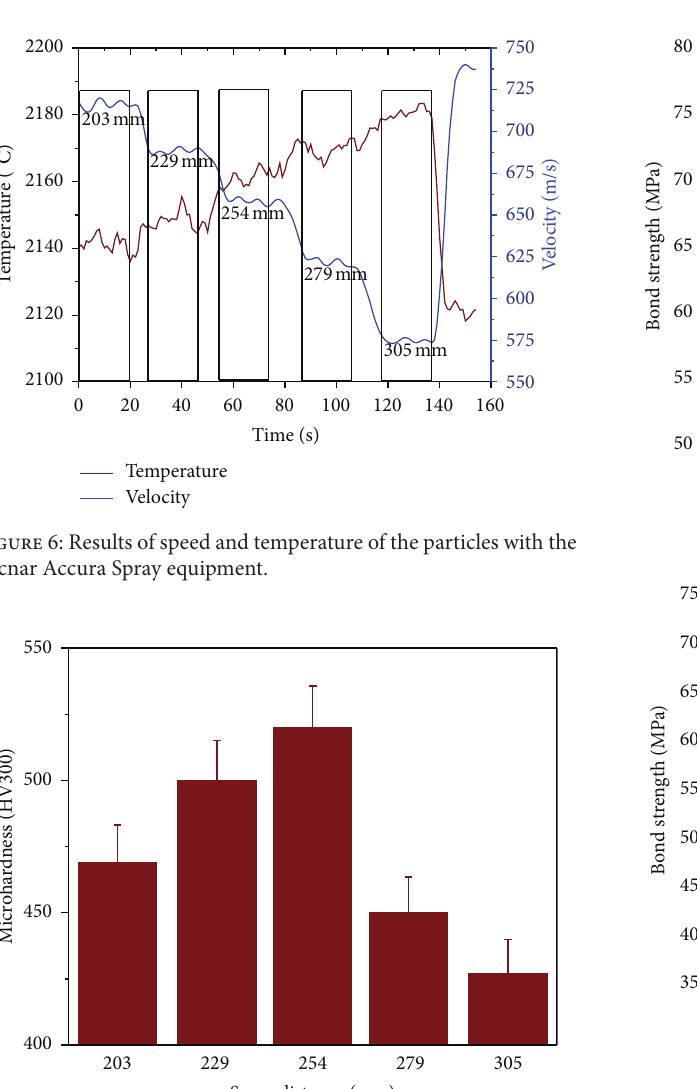
Figure 7: Microhardness Co 32 Ni 21 Cr 8 Al 0.5 Y coating to different spray distances employed.